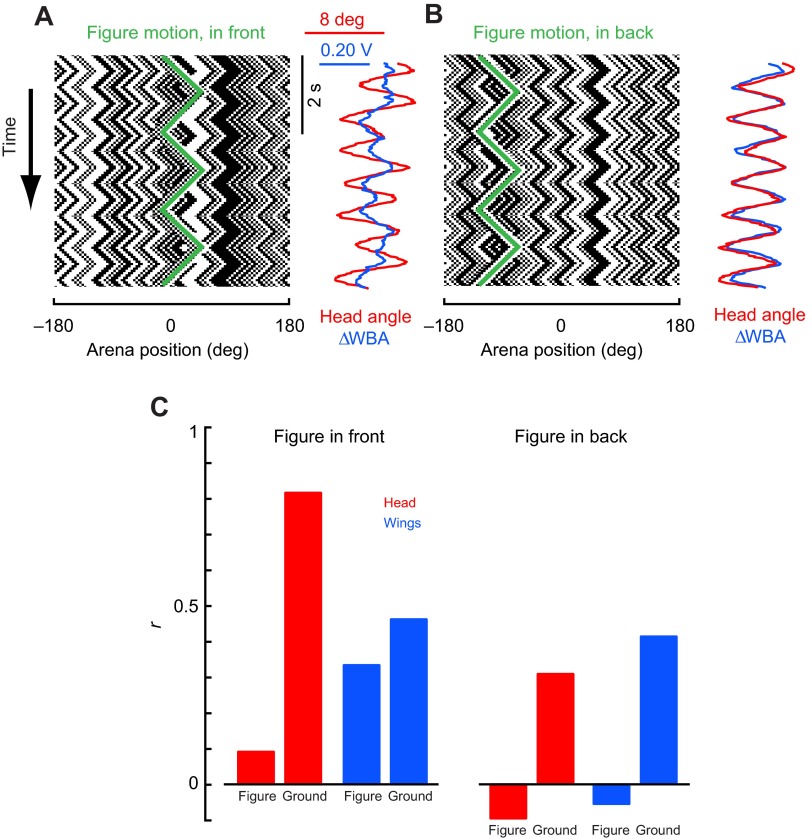
Head and wing responses to triangle-wave figure and ground stimuli with the figure stimulus appearing in the front or the back of the fly's visual field. (A) Space–time plot of the stimulus, with the figure on the visual midline, and average responses for figure motion in the front of the visual arena. Wing-steering responses represent a composite of the figure motion and the wide-field motion, while head angle responses are similar to wide-field motion only. (B) Space–time plot of the stimulus and average responses for figure motion in the rear of the visual arena. Here, both wing and head responses are similar to the wide-field motion. (C) Correlations between the wing-steering (blue) or head-movement (red) response and the motion of each part of the stimulus for figures in the front (left) or the back (right) of the visual field. N=15 flies, 150 trials of each experiment, figure motion 60 deg and ground motion 30 deg in total peak-to-peak amplitude.